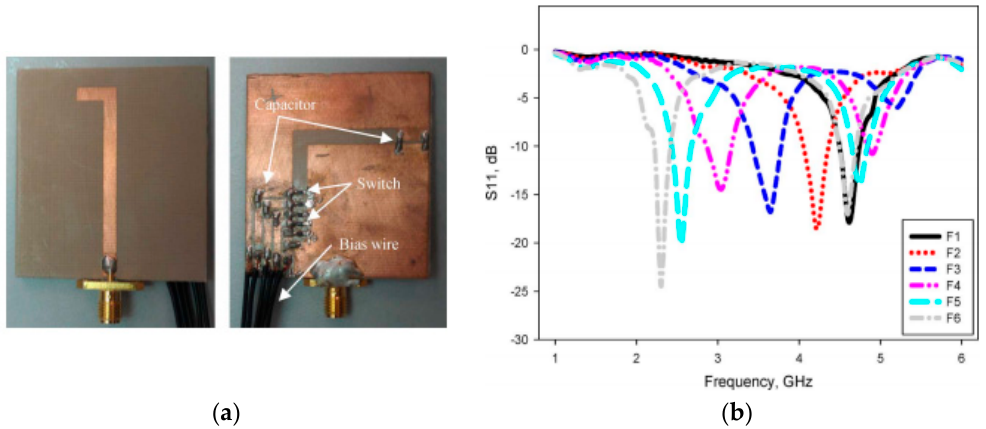
Figure 8. The reconfigurable antenna reproduced from [48]. 2020, IEEE: ( a ) prototype structure; ( b ) measured S-parameter results.